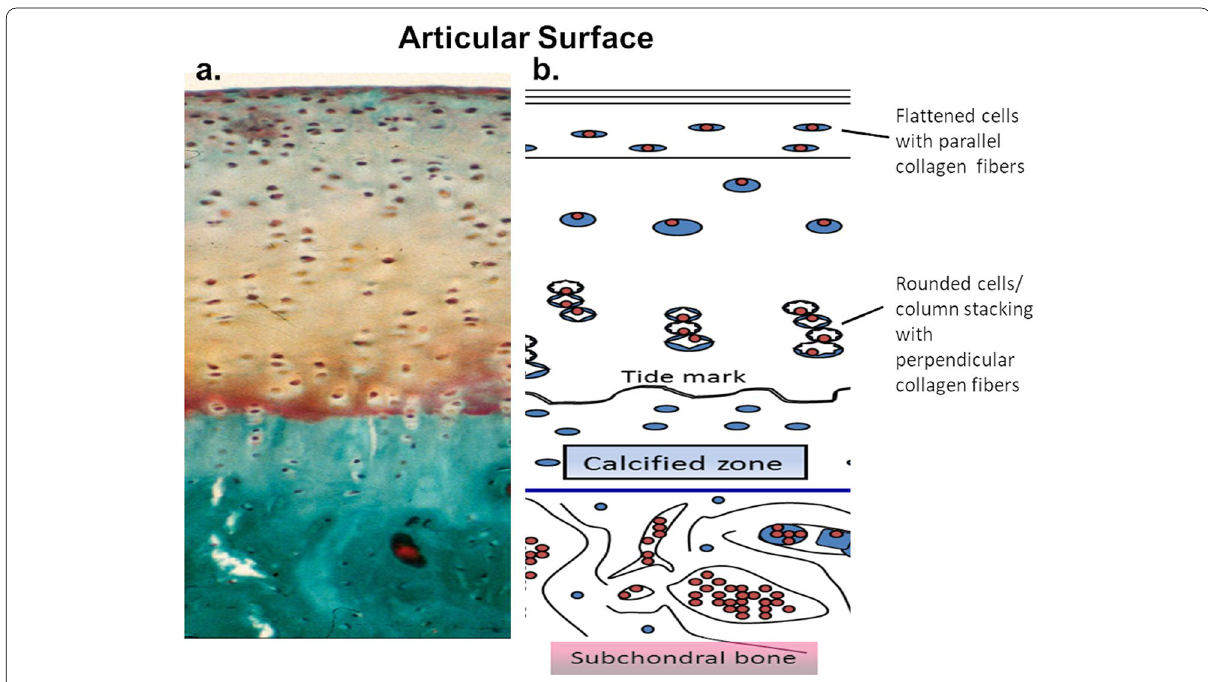
Fig. 5 Organization of articular cartilage a ) Histological section of cartilage stained with safranin‑O/Fast green. b ) Depiction of cell and tissue structure. Both chondrocytes and collagen fiber orientation change depending on the location within the cartilage. Near the surface cells are flattened, and fibers run parallel with the articular surface, while in the middle to deep zones cells form columns and fibers run perpendicular to the surface. Adapted from